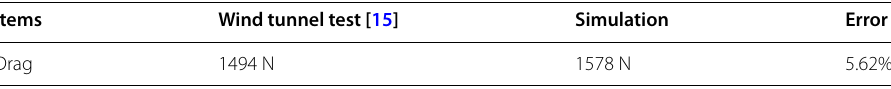
Table 2 Comparison of aerodynamic drag of plates between wind tunnel test and numerical simulation Items Wind tunnel test [15] Simulation Error Drag 1494 N 1578 N